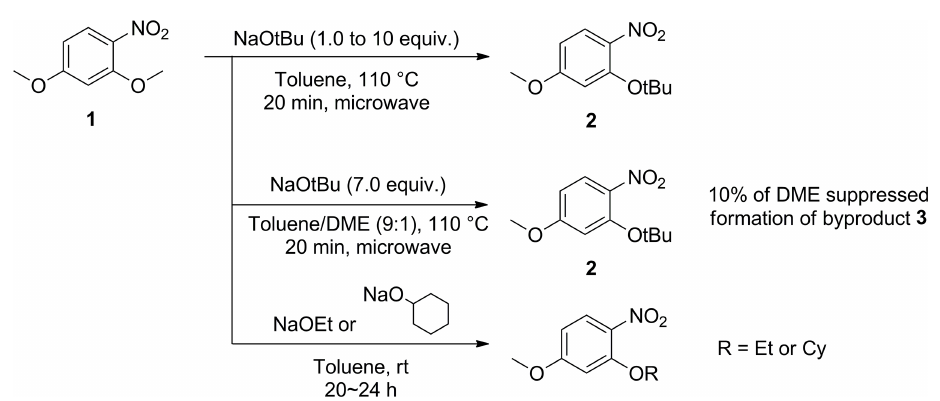
Fig 7. Summary of reaction